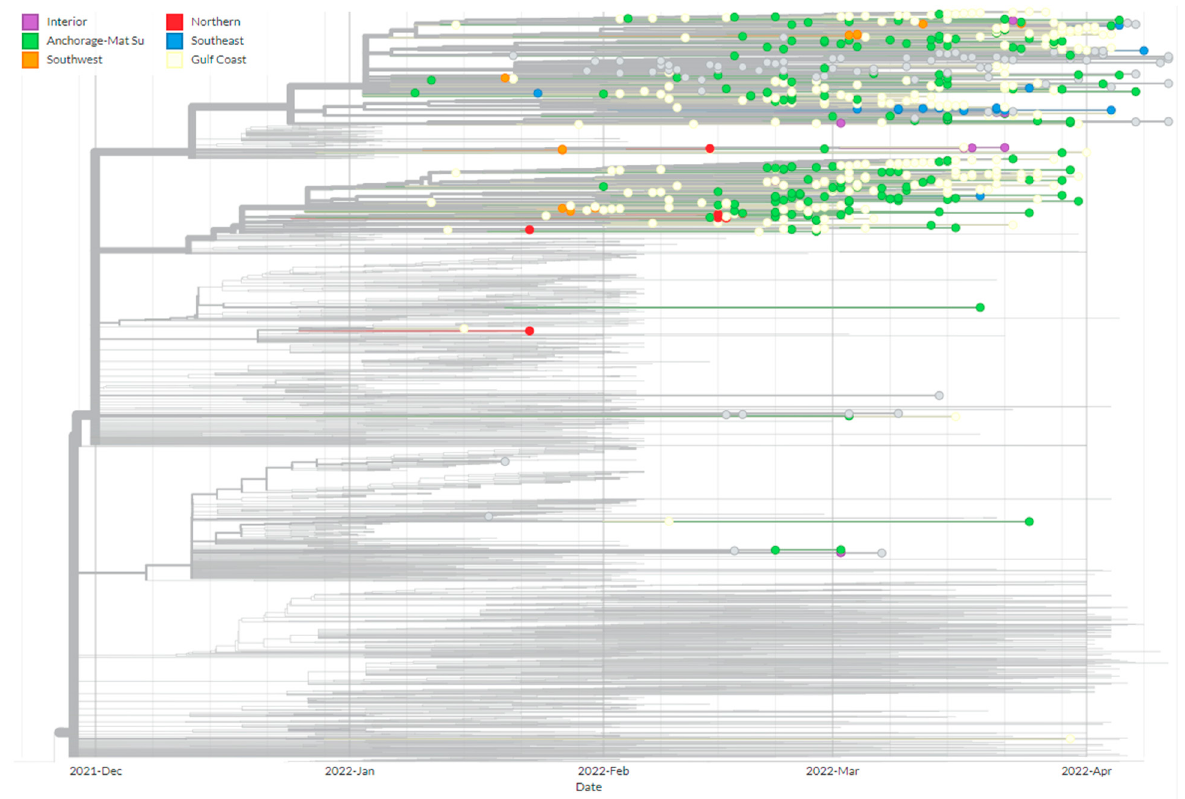
Figure 6. Phylogenetic tree of BA.2.3 cases with branch lengths represented by time. Tree includes all BA.2.3 cases from Alaska, all global BA.2.3 cases from December 2021, and downsampled global cases after December 2021 through the first week of February 2022 for context. Only cases from Alaska are shown and are colored by economic region. Cases where the economic region is unknown are colored gray.